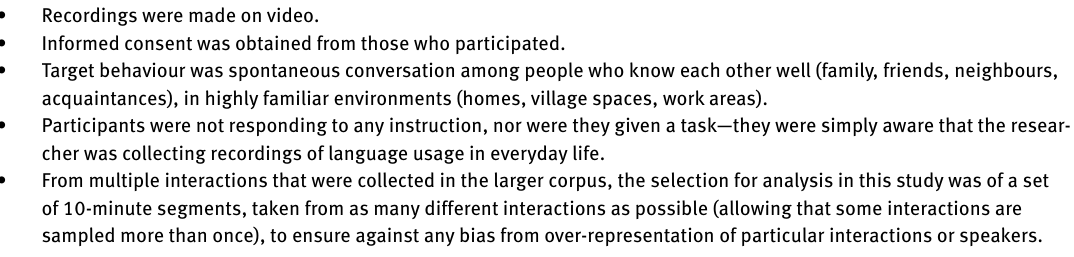
Table 1: Key properties of the data collected for the studies in this